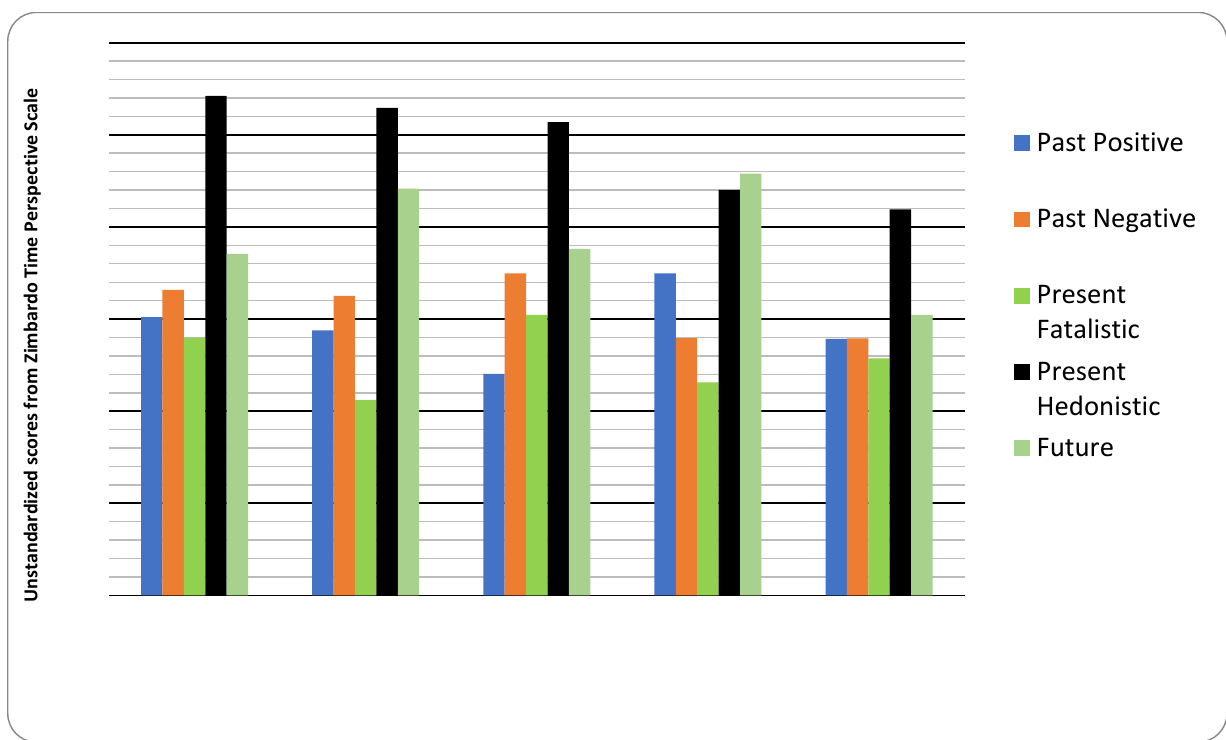
Figure 1. The temporal perspective in five distinctive sub-groups. The results of the aligned rank transformation ANOVA are shown in Table 4. The comparison analysis between pre-COVID-19 and post-COVID-19 adolescents revealed significant differences only in school burnout indicators ( p < 0.001 for SSBS, BFH, NRTF, and FIS; p = 0.003 for BFS; p = 0.023 for BFTA). Students examined after the COVID-19 outbreak were significantly more burned out than the pre-COVID-19 students. The Cohen’s d effect sizes were large (>0.80) for all variables, except loss of interest (LIS), where the effect size was